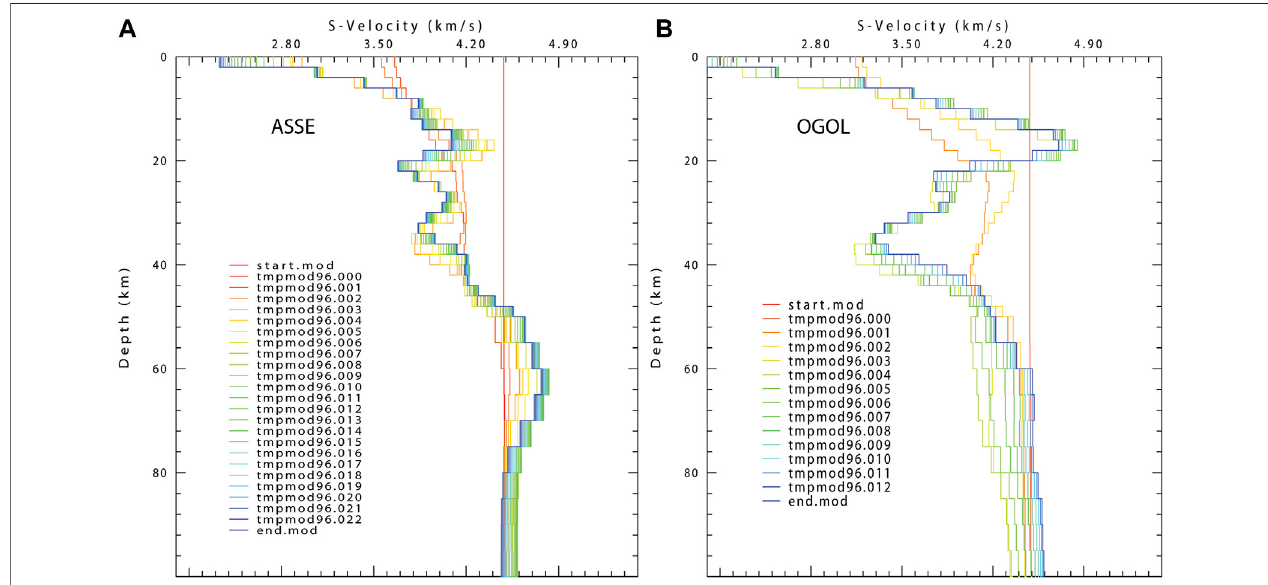
FIGURE 6 | Panels (A) and (B) are the two representative velocity models for the ASSE and OGOL stations. The nearly vertical start. mod is an initial half space velocity model derived from the ak135 global velocity model (Kennett et al., 1995) and the end. mod is the fi nal and best- fi t velocity model. The tmpmod96. xxx are the calculated velocity models from the relatively less fi t RFs during an inversion.